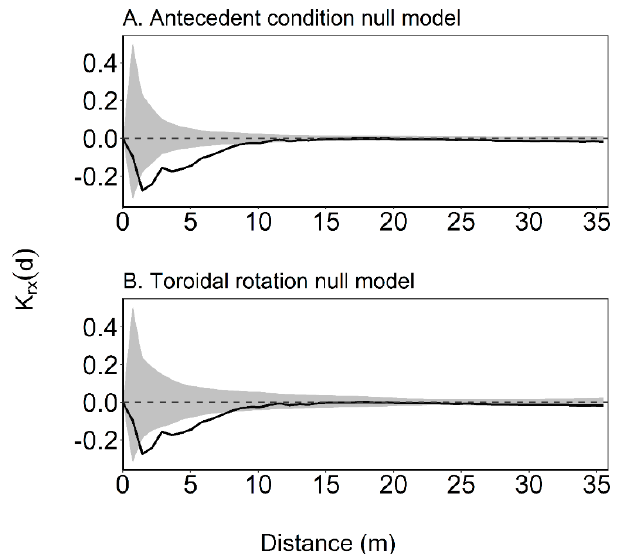
Figure 4. Intertype K rx ( d ) function (continuous lines) between adult trees (stems with dbh ≥ 10 cm) and sapling density (stems with height ≥ 1.30 m and dbh < 10 cm) and the 95% quantile bounds corresponding to the null models ( A : antecedent null model, B : toroidal shift null model). Positive values of the intertype function indicate a positive influence between sapling density and adult trees and negative values of the intertype function suggests the negative influence of adult trees on sapling density.